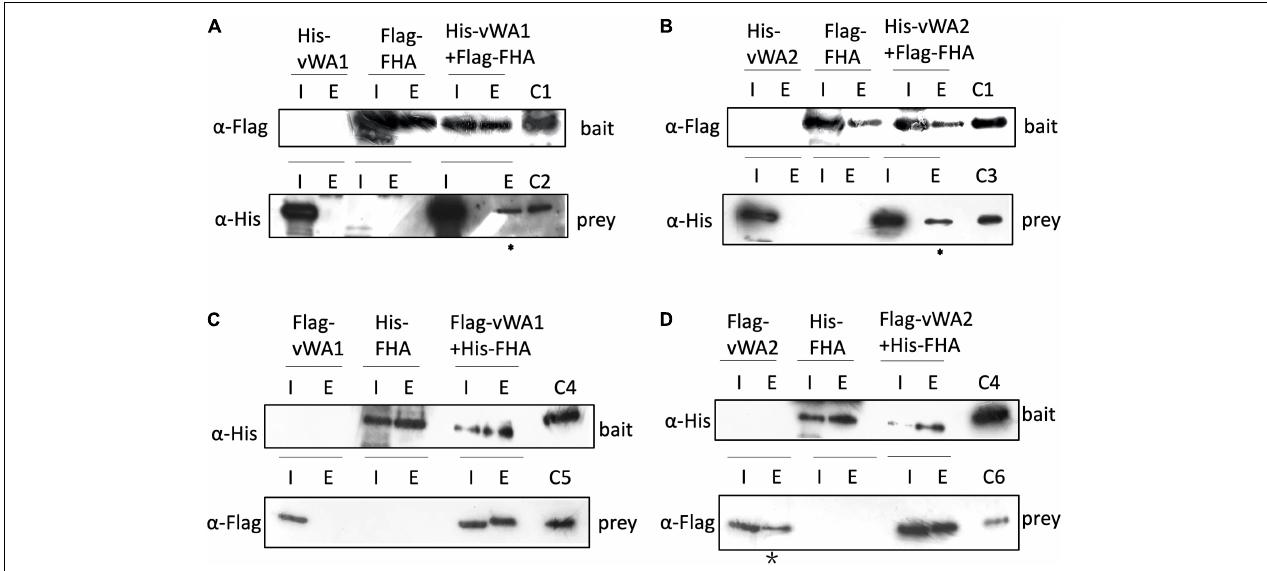
FIGURE 5 | Interaction of FHA and vWAs by pull down. (A,B) Co-purification of His-vWA1 (A) /vWA2 (B) and Flag-FHA in E. coli . His-vWA1 (or vWA2) and Flag-FHA were co-expressed in E. coli . Five hundred milliliters of the E. coli cells were resuspended in 40 ml buffer A and protein samples were prepared as described in the section “Materials and Methods.” Total soluble protein and the enriched sample (20 µ l) from approximately 40 ml supernatant (0.05%) and 9 ml elute (0.22%), respectively, were analyzed by Western blot. C1, control of Flag-FHA purified from E. coli ; C2, His-tagged vWA1 purified from E. coli ; C3, His-tagged vWA2 purified from E. coli . The asterisks represent samples concentrated by 12 times (2.6% of the total elute) before loading to the gels. (C,D) Co-purification of Flag-vWA1 (C) /vWA2 (D) and His-FHA in S. islandicus . One hundreds milliliters of S. islandicus cells harboring the co-expression plasmid were cultivated to OD600 ∼ 0.2 and protein samples were prepared as described in the section “Materials and Methods.” Total soluble protein and the enriched sample (40 µ l) from approximately 10 ml supernatant (0.4%) and 2 ml elute (2.0%), respectively, were analyzed by Western blot. C4, His-tagged FHA purified from E. coli ; C5, Flag-vWA1 purified from S. islandicus ; C6, Flag-vWA2 purified from S. islandicus . The star indicates that Flag-vWA2 bound to Ni-NTA beads weakly. I, input; E,